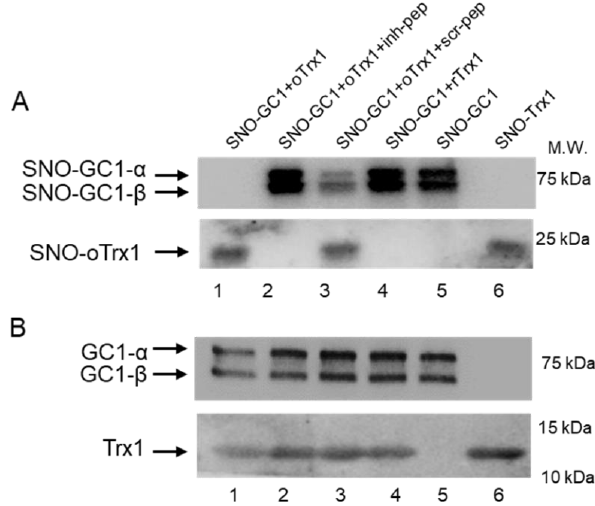
Figure 3. Representative Western blots showing blunted transfer of SNO from GC1 to oTrx1 by the inhibitory peptide. ( A ), Purified GC1 was S-nitrosated with GSNO (SNO-GC1, lane 5); purified Trx1 was oxidized and mixed with SNO-GC1 in the presence of DMSO (lane 1), the inhibitory peptide (lane 2) or the scramble peptide (lane 3). Transfer of SNO from GC1 to oTrx1 (lane 1, DMSO) was blunted by the inhibitory peptide (lane 2) but maintained with the scramble peptide (lane 3). Lane 4 shows that SNO-GC1 did not transnitrosate rTrx1 and lane 5 and 6 were S-nitrosated GC1 and oTrx1 alone. The samples were subjected to biotin switch assays then separated by electrophoresis on a non-reducing 12% SDS-PAGE gel. After transfer, the blots were probed with anti-biotin antibodies (1:3000), to reveal S-nitrosated GC1 (upper panel) and S-nitrosated Trx1 (lower panel). The uncropped Western blots with the “no ascorbate” controls are provided in Figure S7. ( B ), Western blots of the starting materials used in 3A, ran on a reduced 12% SDS-PAGE gel, then transferred and probed with anti- α , anti- β (upper panel), and anti-Trx1 (lower panel) antibodies. Note that in A and B, Trx1 migrates as a dimer and a monomer, respectively, and as expected with a non-reducing ( A ) vs. a reducing ( B ) gel